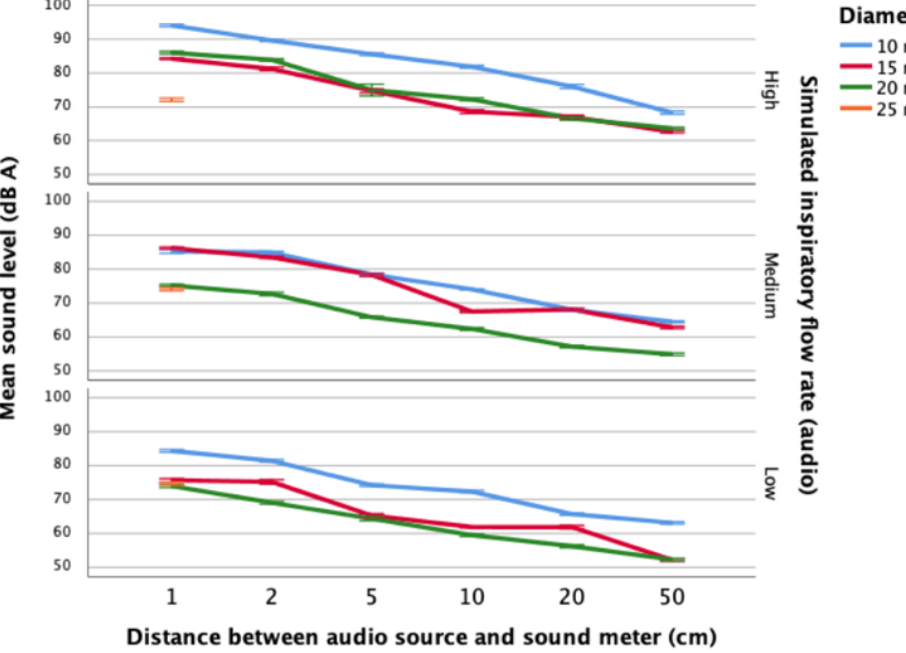
Figure 5. Sound levels of syringe-simulated inspirations by distance, flow rate and mouth diameter. The association of distance, flow rate and mouth diameter with sound levels arising from simulating inspirations using the calibration syringe was significant (F 3,851 = 835.231, p < 0.01), accounting for 74.6% of the observed variability in sound levels (adjusted R 2 = − 0.746). See Supplementary Materials file for the regression model. Distance (ß distance = − 0.706, p < 0.00) explained more than twice the variability in sound levels compared with either flow rate (ß flow rate = − 0.374, p < 0.01) or mouth diameter (ß mouth diameter = − 0.398, p < 0.01). The highest peak inspiratory flow rates were measured when large mouth diameters (e.g., up to 25 mm) were applied using the pneumotachograph (Figure 4). Conversely, the highest sound levels arising from syringe-simulated inspirations were detected where the smallest mouth diameters (e.g., 10 mm) were used (Figure 5). Minimising the distance from the simulated “mouth” nozzle contributed more to producing higher and more audible inspiratory sound, with high syringe-simulated inspiratory flow rates and small mouth diameters also contributing to louder inspiratory sound for detection.